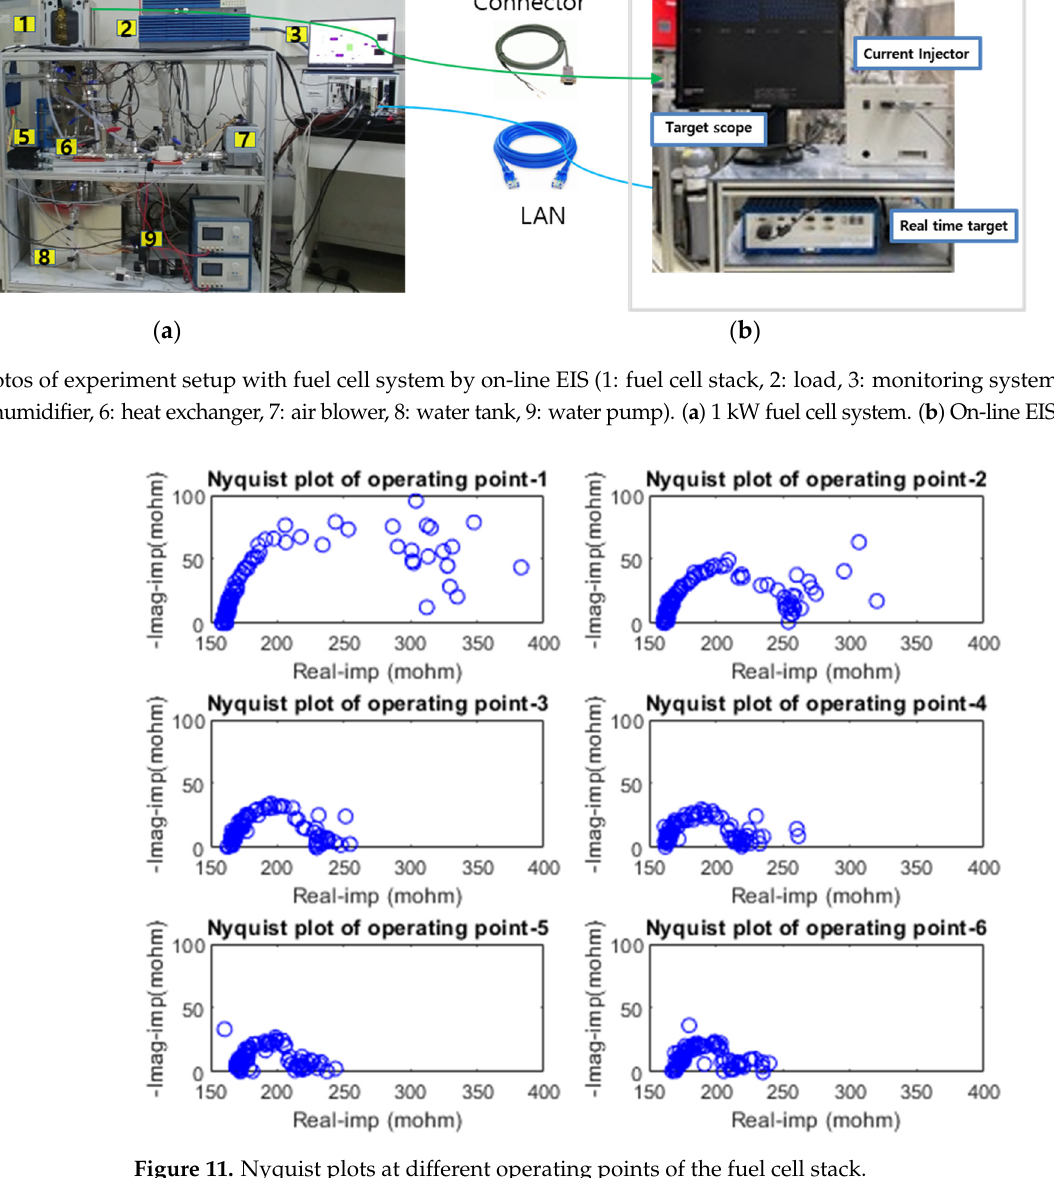
Figure 11. Nyquist plots at different operating points of the fuel cell stack.